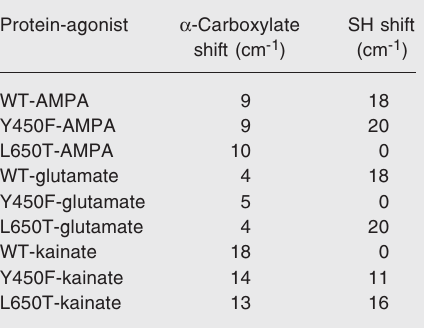
Table 1. Shift in the frequency of the asymmetric α -carboxylate vibration for the agonist bound to the GluR2-S1S2 wild-type (WT), L650T, and Y450F proteins relative to the frequency in buffer and of the Cys 425 S-H stretching vibration in the agonist-bound state relative to the frequency of the vibration in the apo